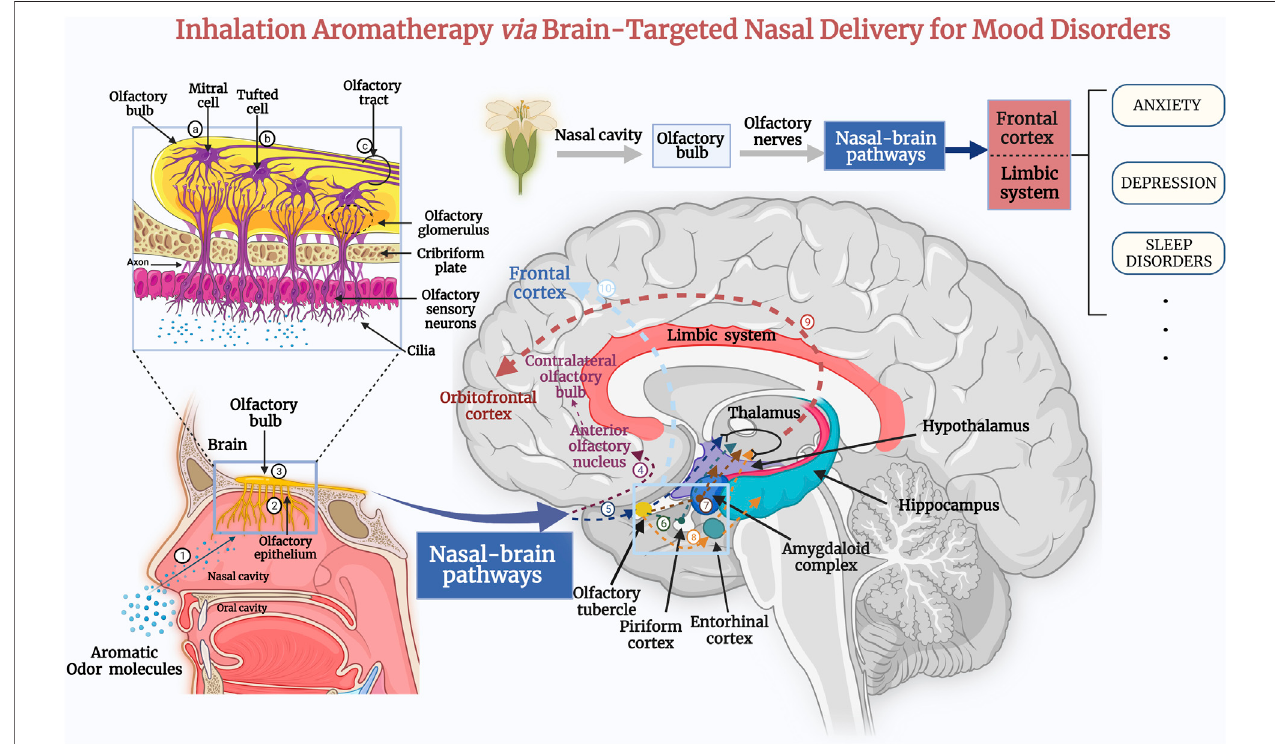
FIGURE1| Inhalationoftheextractsofaromaticplant via thenosesendssignalsdirectlytotheolfactorysystem,whereodormoleculestargettherapeuticdrugsto braintissue via nasal – brainchannels. Subsequently, they act onthe cerebral cortex,the thalamus, and the limbicsystem ofthebrain,and stimulatethe braintoproduce neurotransmitterstotreatthesymptomsofanxietyanddepression,aswellasimprovesleepquality(Lvetal.,2013).Thearomaticodormoleculesareinhaledthroughthe nasal cavity (1) to reach the olfactory epithelium (2) of the nasal mucosa (Schneider et al., 2018). First-order neurons transmit the odor-evoked response to the olfactorybulb(3).Intheolfactorybulb,theaxonsofmitralcells(a)andsometuftedcells(b)(secondaryneurons)formtheolfactorytract(c).Theaxonsofsomemitralcells or lateral branchesenterthe anteriorolfactorynucleus (4) and pass tothe contralateral olfactory bulb (Chaet al.,2021). Additional secondary neurons enter the olfactory striatum (medial, lateral, and medial) and then project to central olfactory areas, including the olfactory tubercle (5), piriform cortex (6), amygdala (7), and the entorhinal cortex (8). The entorhinal cortex partially transmits to the hippocampus. Eventually, the central olfactory-area signals are transmitted through the thalamus to the orbitofrontal cortex (9) (Lie et al., 2021). An additional olfactory signaling pathway passes directly from the central olfactory area to the prefrontal cortex (10). These impulses induce the release of neurotransmitters such as serotonin or endorphin, which act as a “ bridge ” between nerves and other bodily systems (Schneider et al., 2018; Smith and Bhatnagar, 2019).